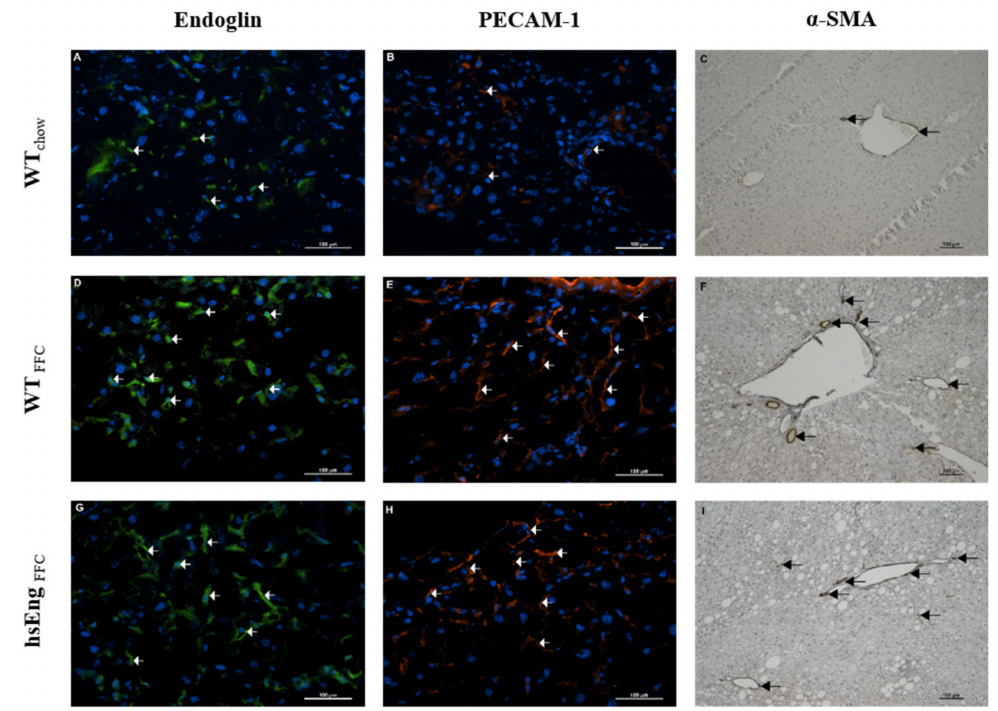
Figure 3. Representative pictures of immunohistochemical staining for Eng, PECAM-1, and anti- α -smooth muscle actin ( α -SMA) in mice liver. Eng expression (green) is marked by arrows (white) in WT chow ( A ), WT FFC ( D ) and hsEng FFC ( G ) mice. PECAM-1 expression (red) is marked by arrows (white) in WT chow ( B ), WT FFC ( E ) and hsEng FFC ( H ) mice. Nuclei staining in blue. α -smooth muscle actin (brown) is marked by arrows (black) in WT chow ( C ), WT FFC ( F ) and hsEng FFC ( I ) mice. Scale bar 100 µ